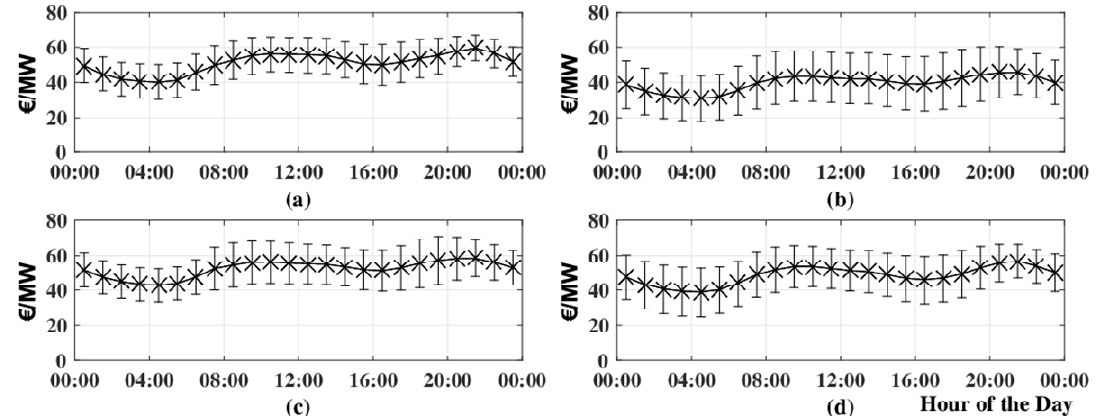
Figure 12. Mean hourly Spanish day-ahead market price with standard deviation for 2015 ( a ), 2016 ( b ), 2017 ( c ), and 2018 ( d ) [41].